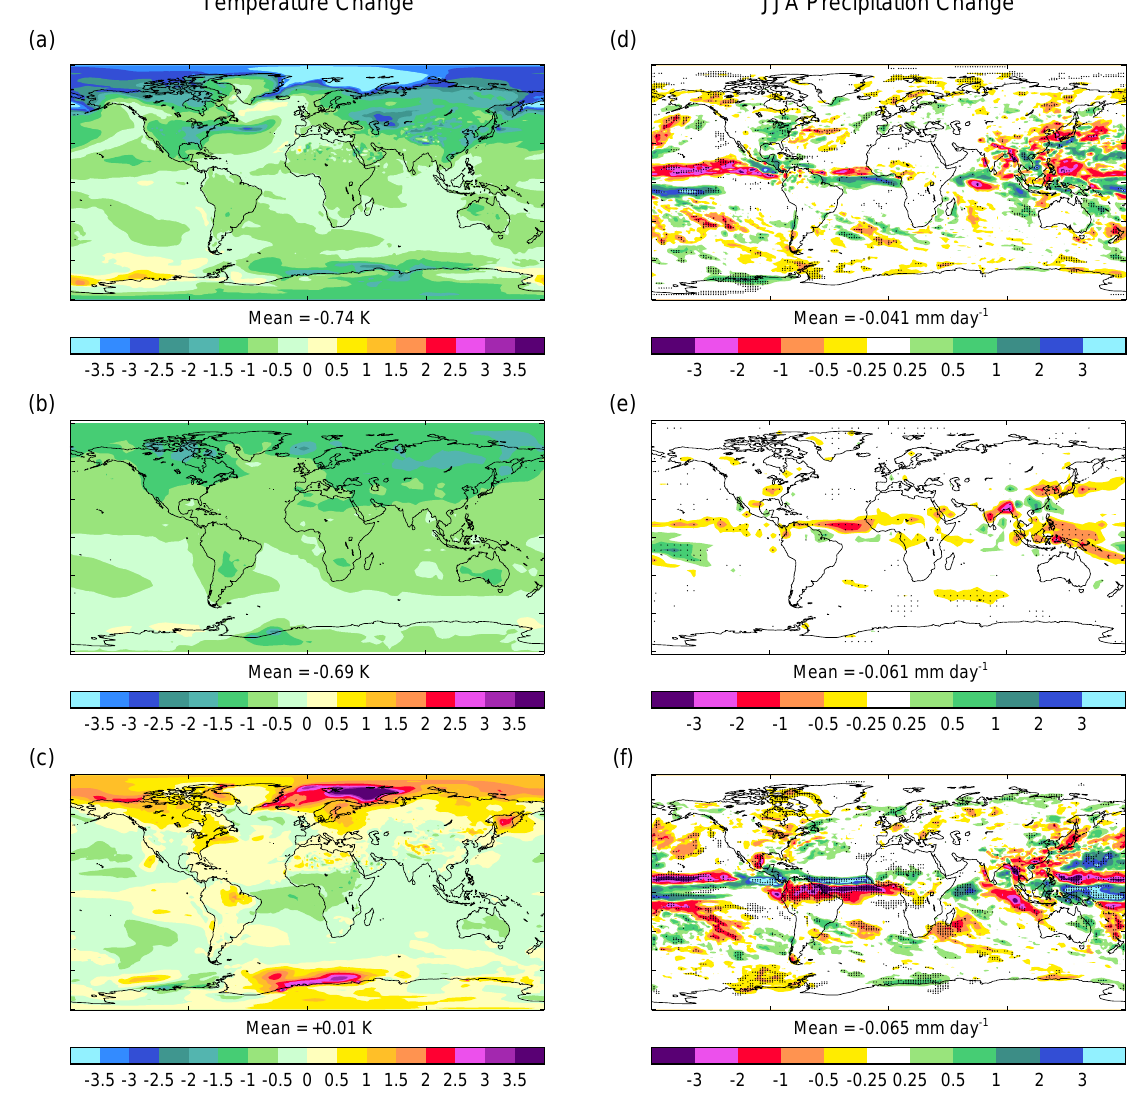
Fig. 4. (a) Difference in annual-mean near-surface air temperature (K) between the A1B-plus-geoengineering and A1B simulations in HadGEM2, meaned over the second decade of simulation. (b) As (a) but for ModelE. (c) As (a) but comparing years 29–38 of the A1B-plus-geoengineering simulation with the 1990–1999 period in a historical simulation. (d) As (a) but for change in mean June-August precipitation rate (mmday − 1 ) in HadGEM2; areas where changes are significant at the 5% level are indicated by dots. (e) As (d) but for ModelE. (f) As (c) but for change in mean June–August precipitation rate.